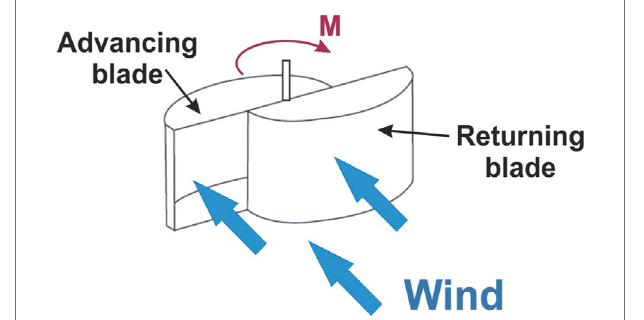
FIGURE 1 | Conventional Savonius rotor (Gupta et al., 2008).